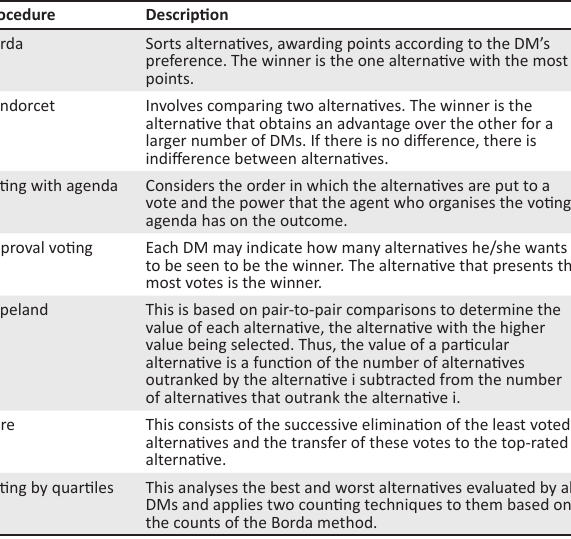
TABLE 1: Voting procedures. TABLE 2: Characterisation of the groups of criteria for service provider